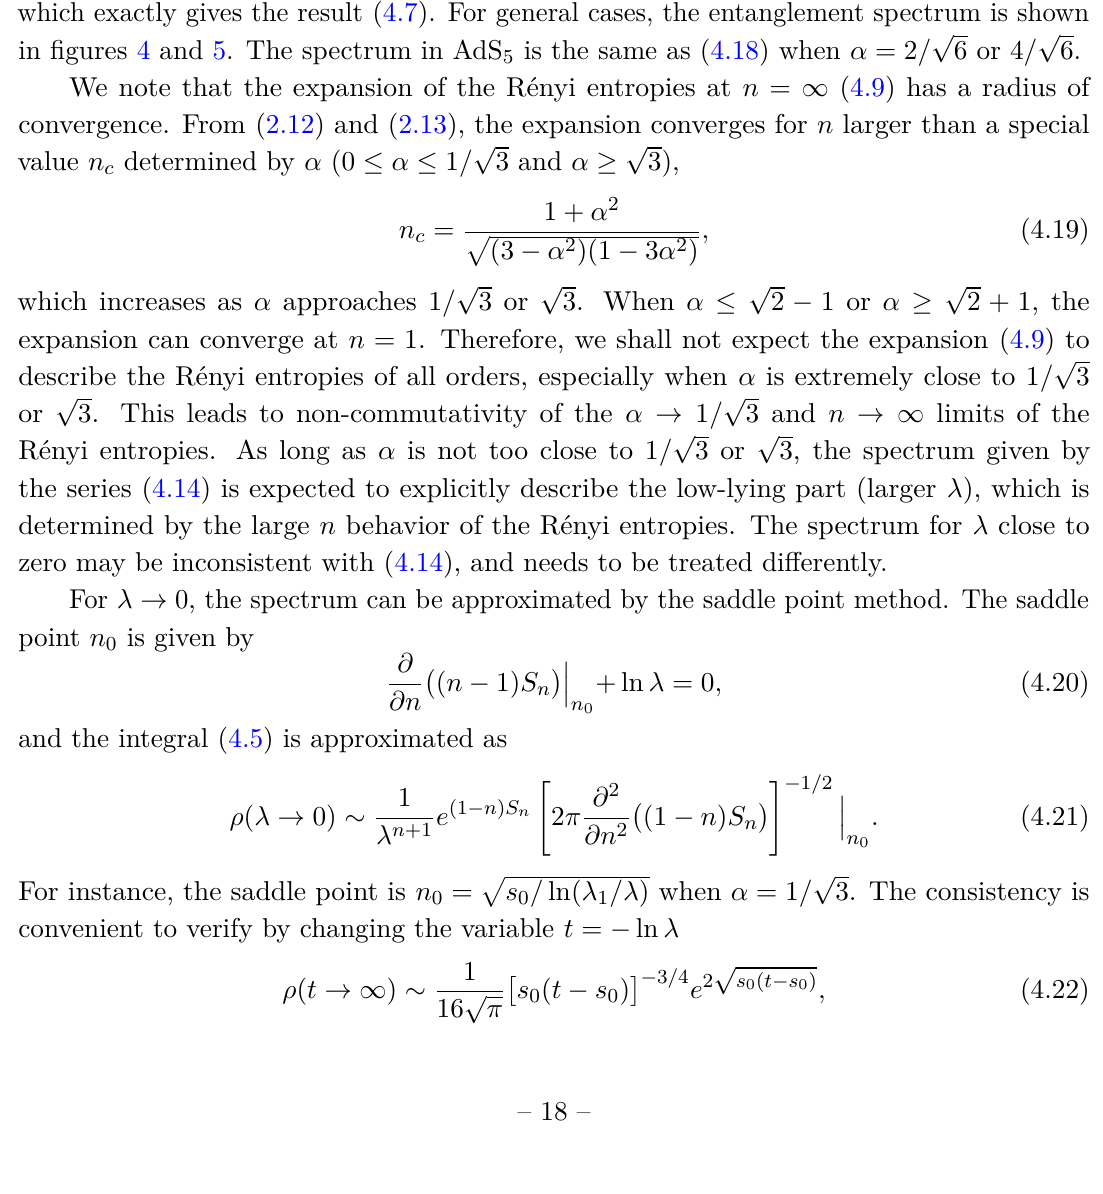
Figure 4 . The entanglement spectrum as a function of λ . The dashed line is for the SAdS 4 black hole, while the solid lines are for hairy black holes, with α = 0 . 52 (orange line) and 1 / (blue line). The largest eigenvalues are 0.857, 0.869, 0.882, respectively. The largest eigenvalue as a function of α is shown in the